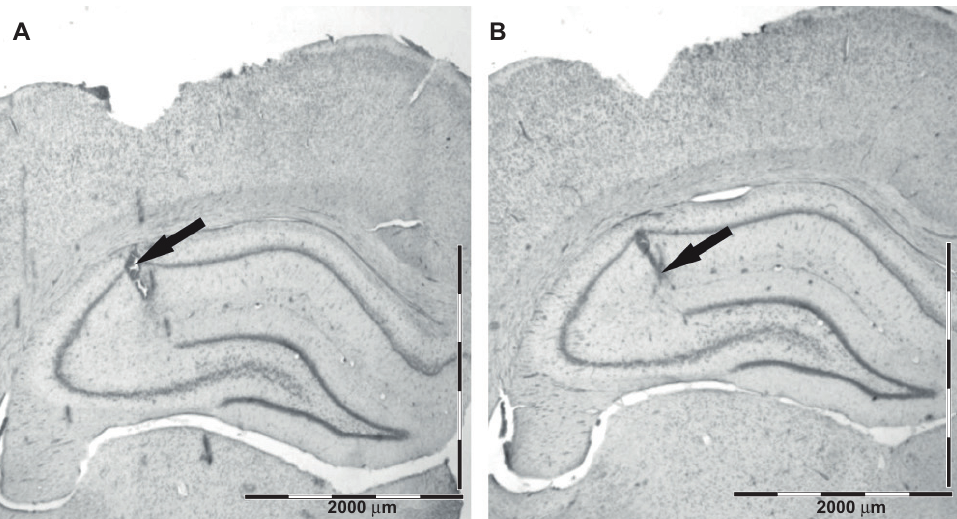
Figure 1. Histological verification of the electrode placement in the hippocampus. The arrows point to the lesion marks corresponding to the two electrode tips, the upper one in the alveus/oriens and the deeper one in the hippocampal fissure. Scale bar = 2000